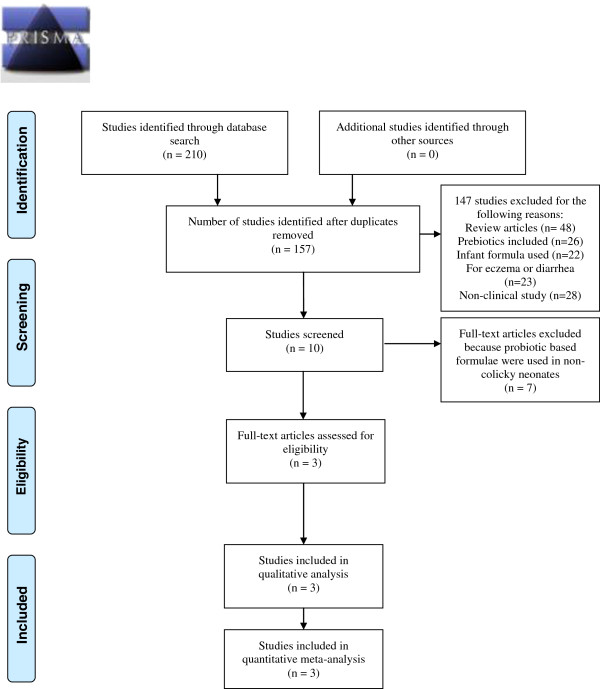
PRISMA flow diagram 2009 of included studies.